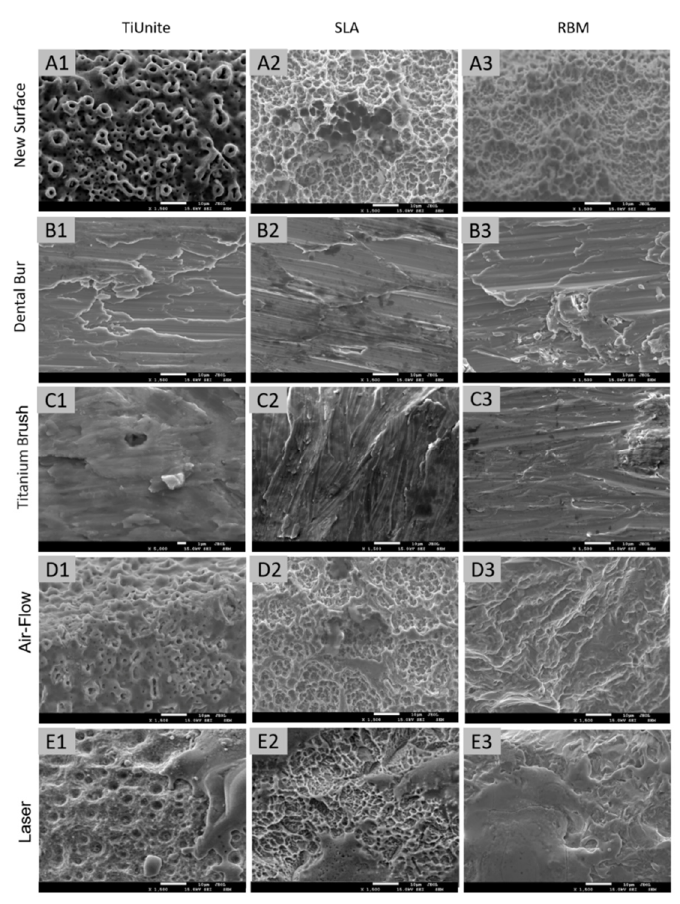
Figure 3. Impact of the cleaning method on the implant surface. Scanning electron microscopy (SEM) imaging of the surfaces of new untreated ( A ) implants TiUnite ( 1 ), SLA ( 2 ), and RBM ( 3 ), as well as the implants from the same, manufacturers isolated from the patients with peri ‐ implantitis and cleaned with different methods: dental bur ( B ), titanium brush ( C ), air ‐ flow ( D ), and laser ( E ). and cleaned with different methods: dental bur ( B1 – B3 ), titanium brush ( C1 – C3 ), air-flow ( D1 – D3 ), and laser ( E1 – E3